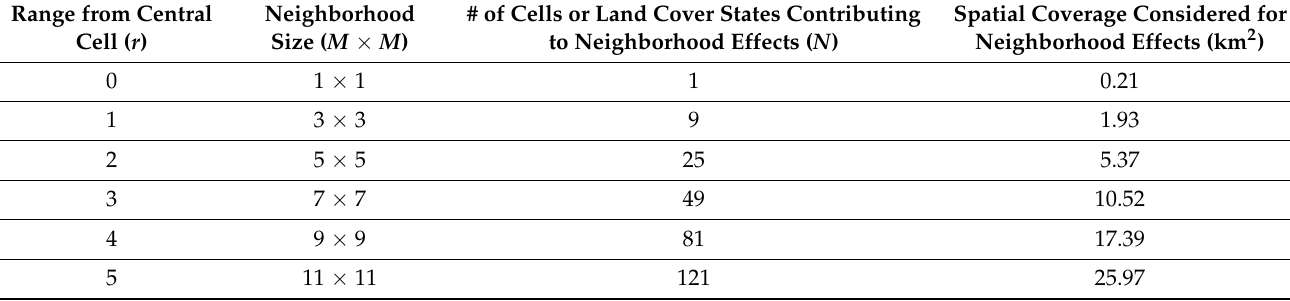
Table 2. Surface area covered by a training sample with each neighborhood configuration. A Moore neighborhood encompasses N cells given a range parameter r specifying the distance from the central cell, where N = ( 2 r + 1 ) 2 .